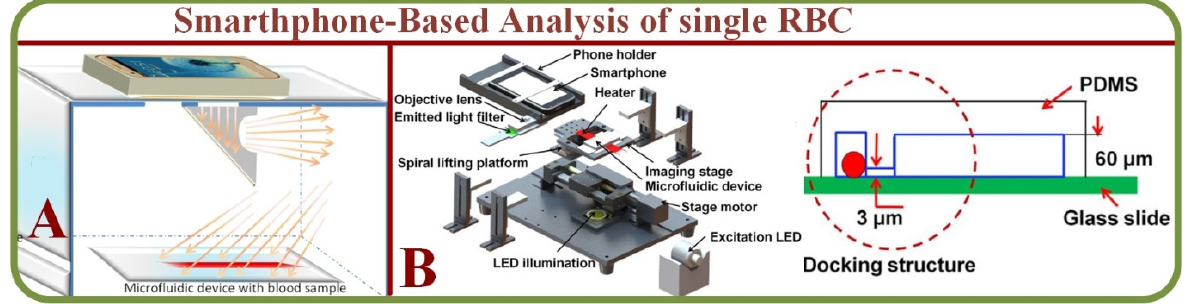
Figure 4. ( A ) A smartphone-based optical platform for the colorimetric analysis of different hematocrit samples without and with PDMS light diffuser and the corresponding gray scale values [52].